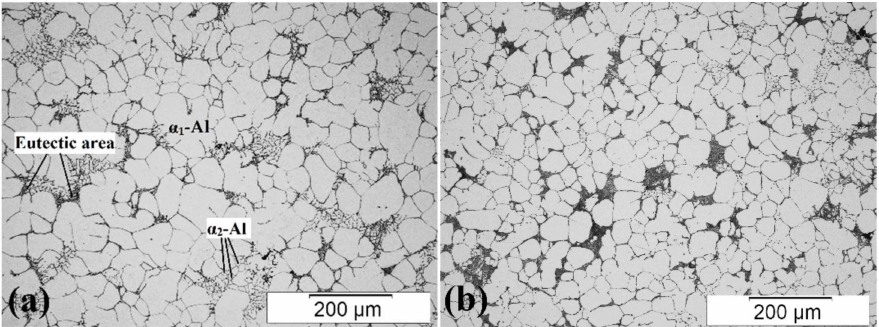
Figure 4. LOM image of sample ( a ) 2.5 RGB and ( b ) 4.5